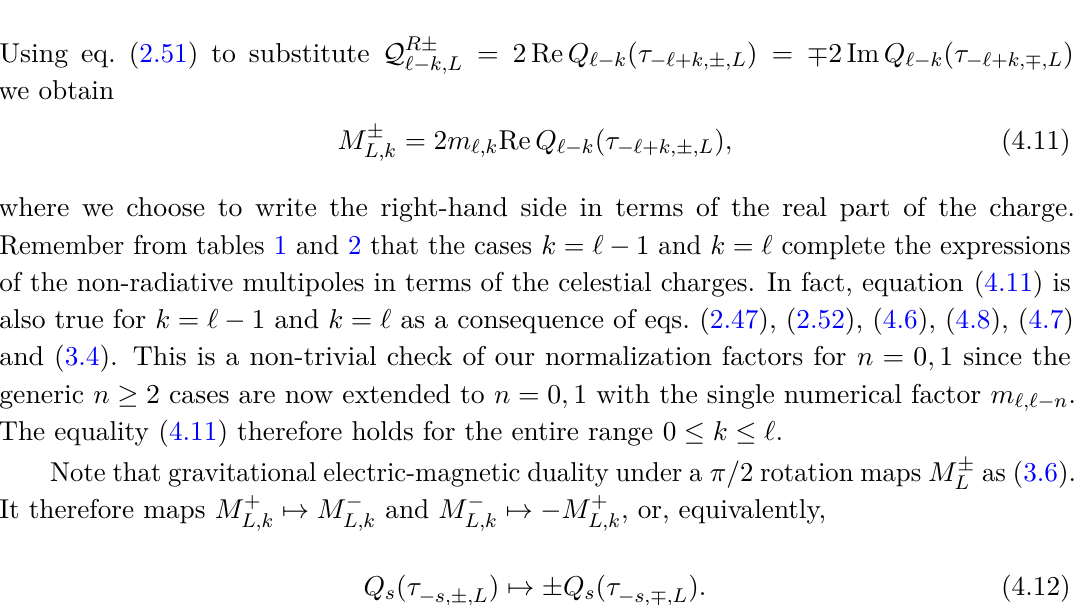
Table 2 . First sets ( ‘ ≤ 3 ) of parity-odd conserved charges of non-radiative asymptotically flat spacetimes. The symbol ∼ means “is proportional